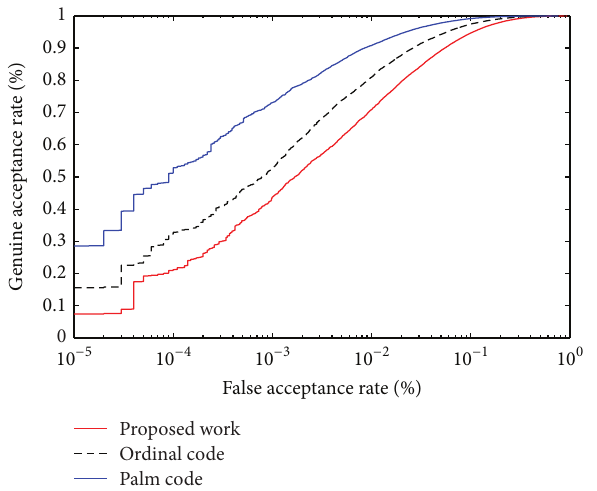
Figure 11: ROC curve using local features of proposed DOST for PolyU palmprint database.